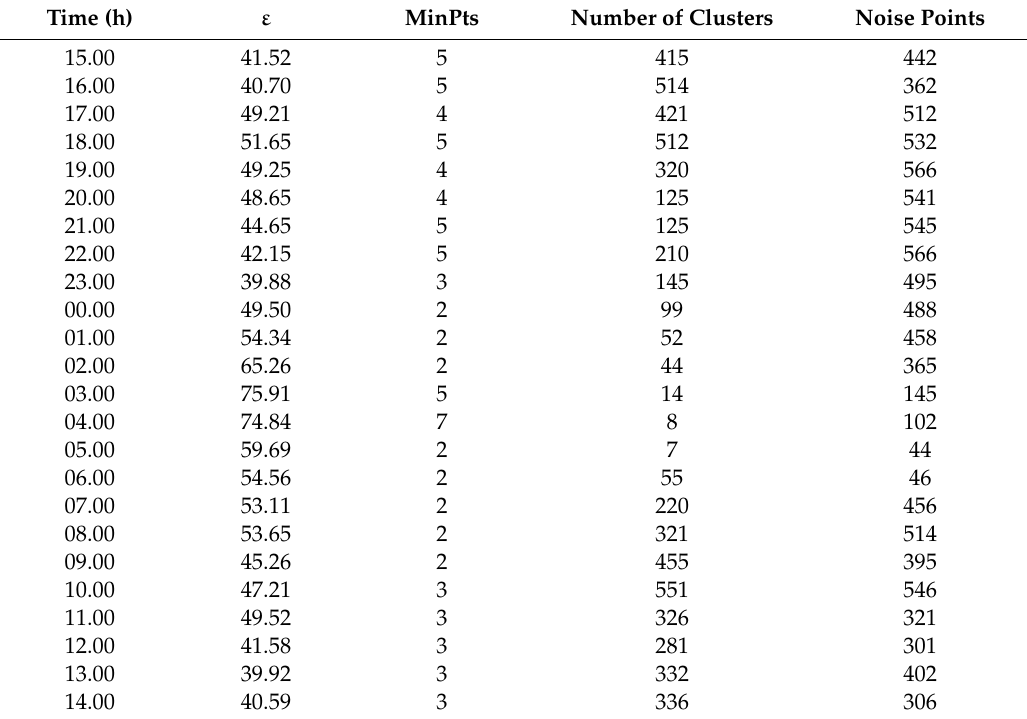
Table 4. SOM and DBSCAN, first stage clustering results in New Year’s Eve, 2018 in Madrid